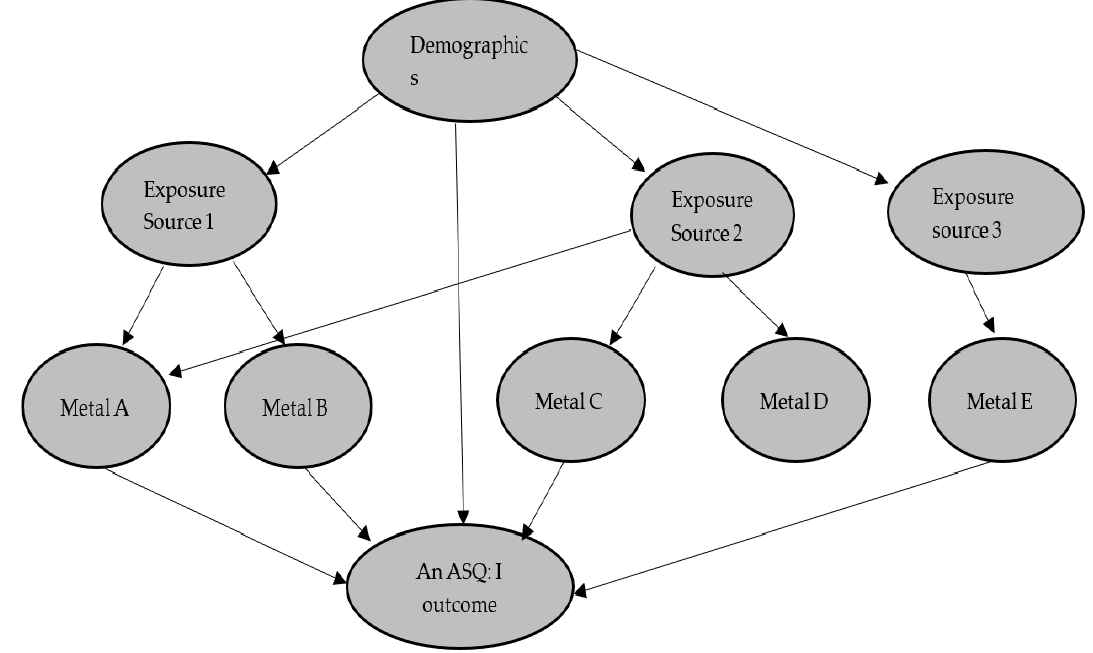
Figure A1. Causal diagram for association between metals and an ASQ:I outcome.